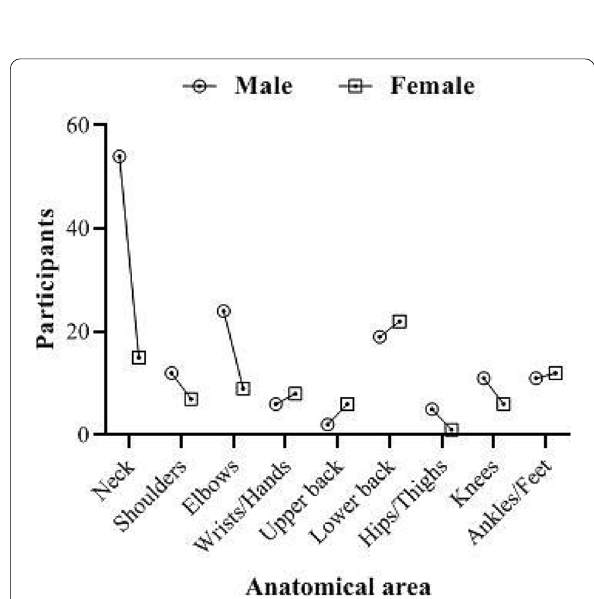
Fig. 1 Illustration of WMSD affected anatomical areas considering